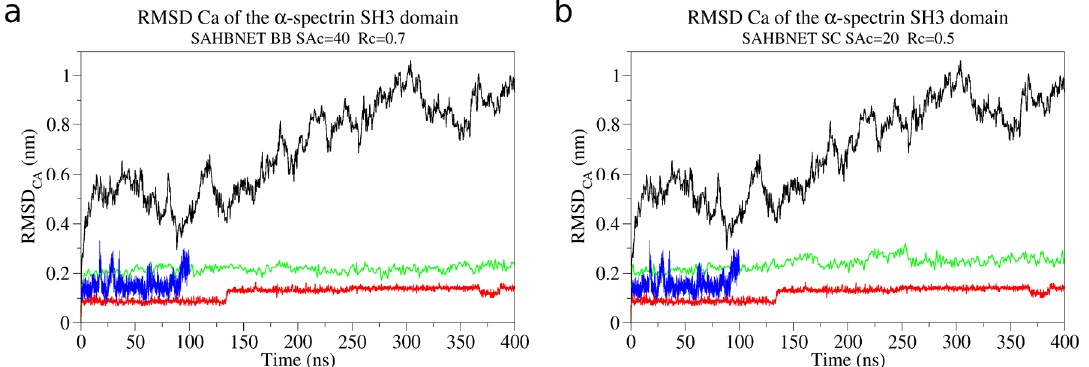
Figure 3. Behavior during longer time scale: The RMSD of the C α over time is presented for the α -spectrin SH3 with SAHBNET (green) BB [( a ) SA K 1000 kJ mol − 1 nm − 2 ] and SC [( b ) SA SPRING K 1000 kJ mol − 1 nm − 2 ], with ELNEDYN (red), without network (black) or from SPRING atomistic simulation